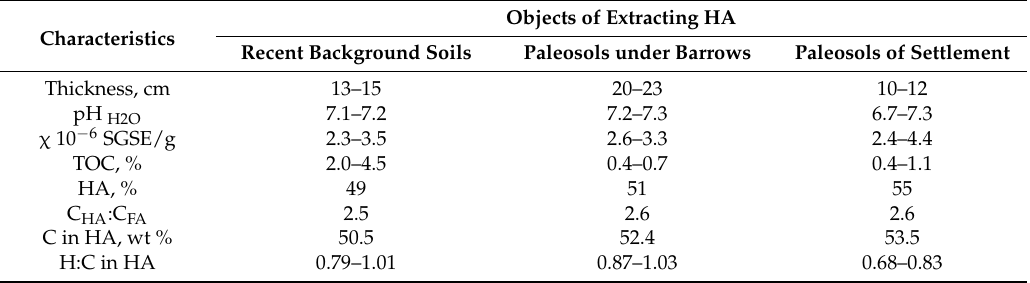
Table 1. Characteristics of humus horizons of soils, paleosols, and humic acids (HAs) isolated from them. Characteristics